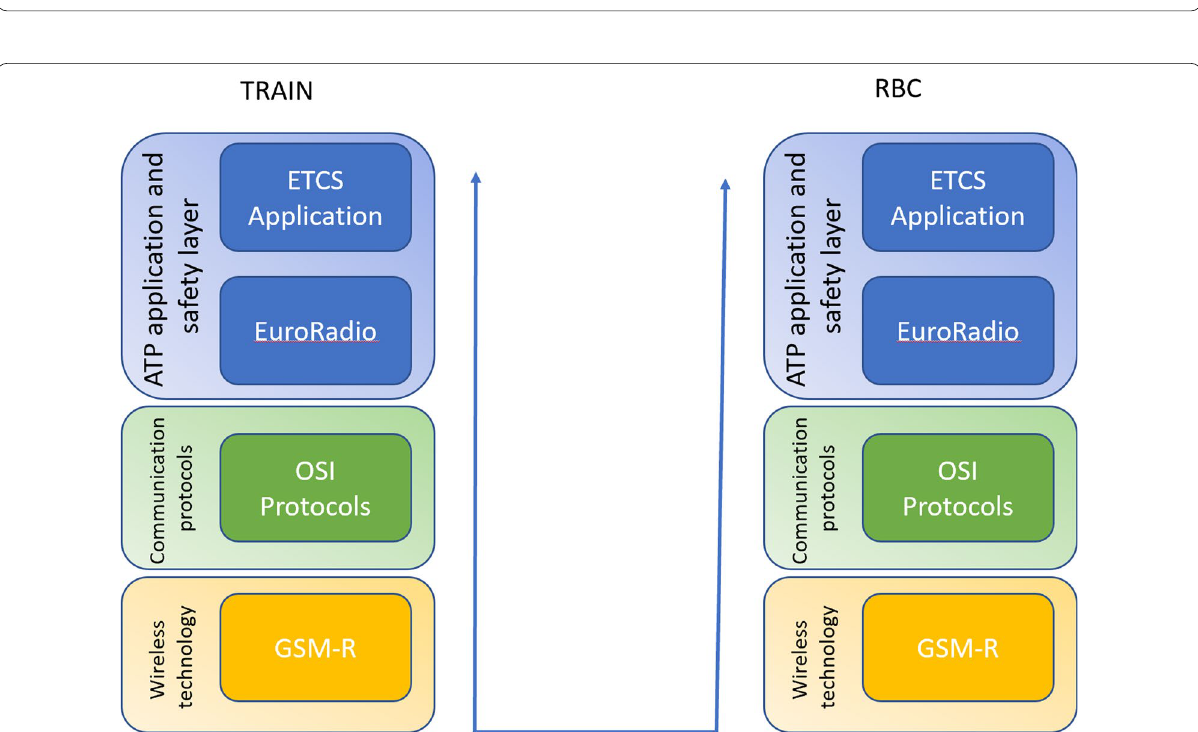
Fig. 2 Communication architecture, inspired by Pinedo et al.